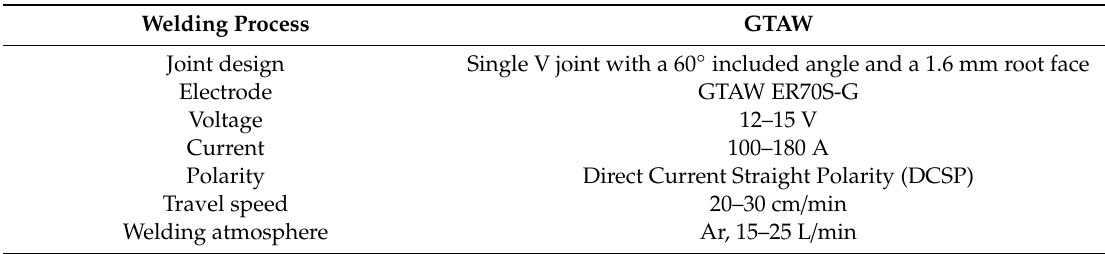
Table 3. Welding procedure